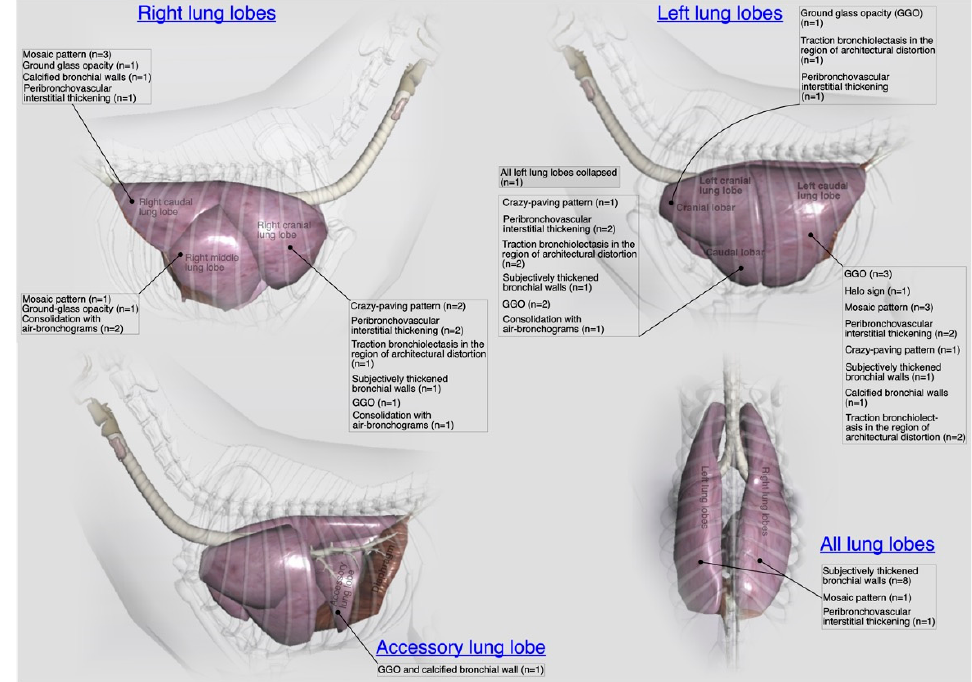
Figure 15. An illustrative summary of the localized computed tomographic abnormalities of the pulmonary parenchyma (individual lung lobes and lobules) and their relevant blood vessels in terms of their laterality in a total of 22 cats presented with acute/chronic infectious respiratory disease signs.